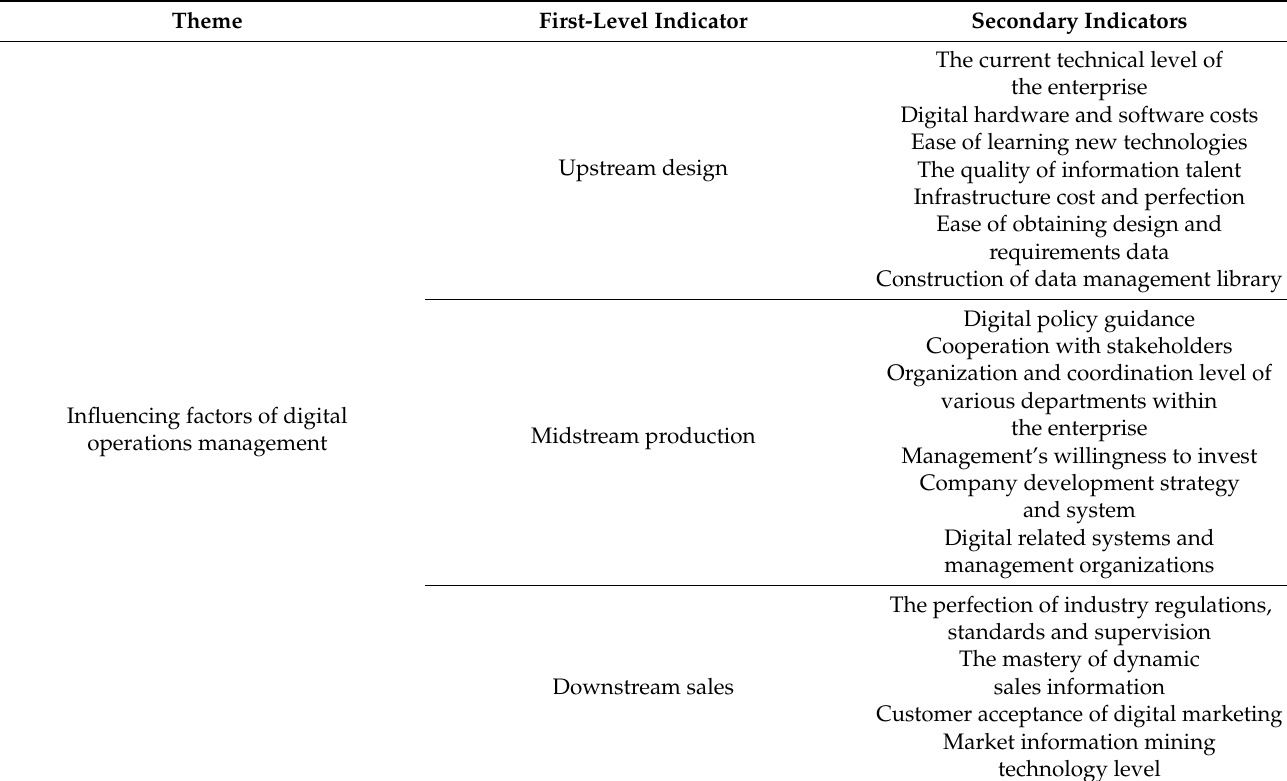
Table 1. Influencing factor